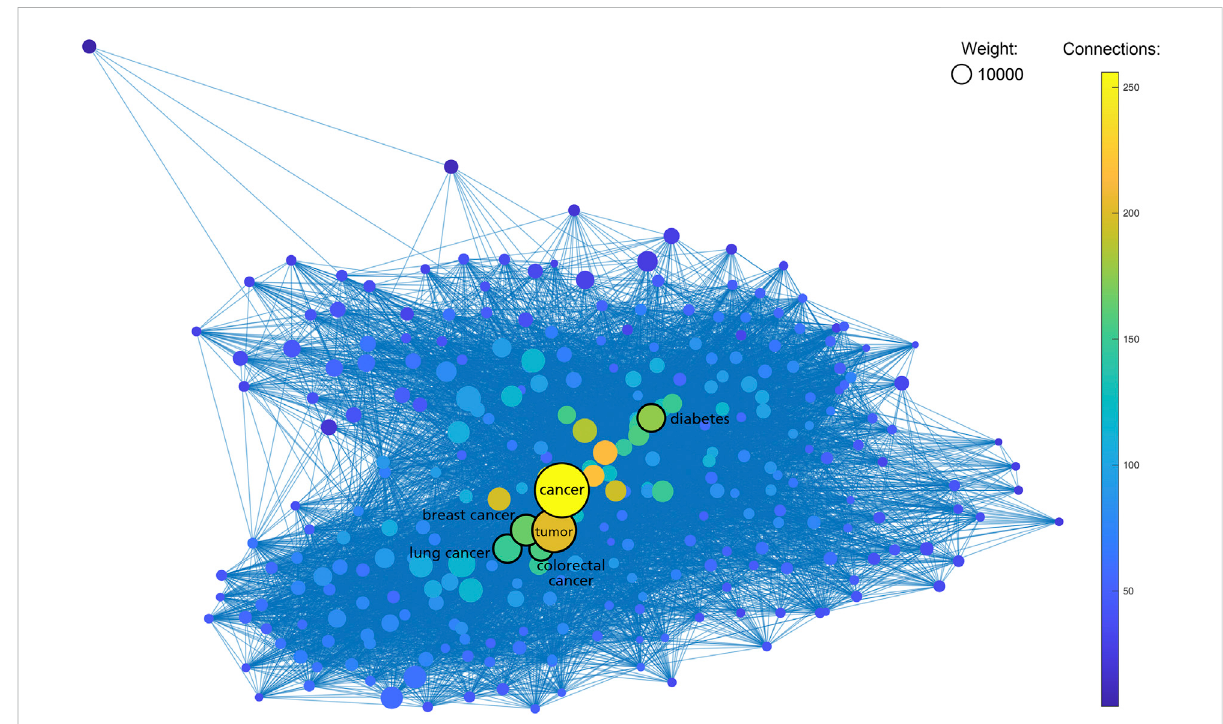
FIGURE 3 Graphcontaining654SNPMapkeywords(nodes)andtheirinternalconnections(edges).Keywordswithlesstentotalcountsor50connections are excluded. Sizes of nodes represent the total counts of keywords. Colors of nodes represent the numbers of connections to